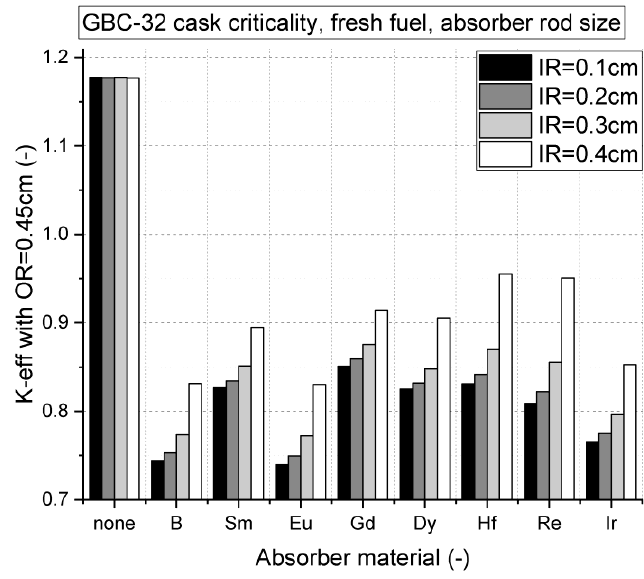
Figure 4. Absorber inner hole size selection